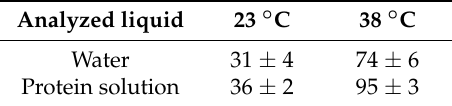
Table 1. Value of charge accumulated in the cell without an electric field, in